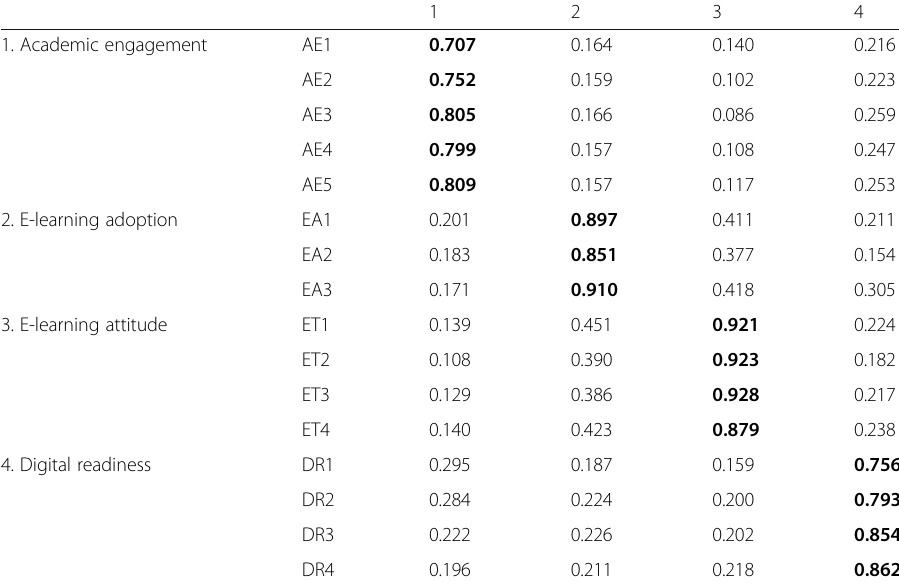
Table 4 Matrix of loadings and cross-loadings of variables in the measurement model